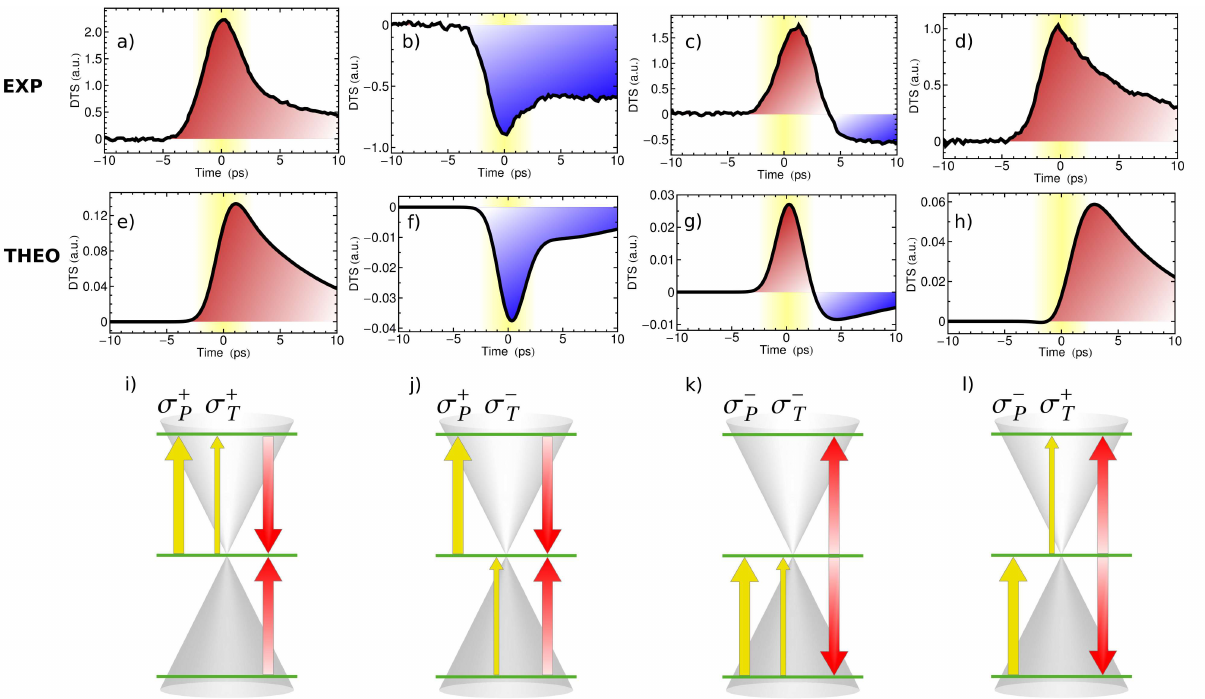
Figure 9: Polarization-resolved differential transmission. Time dependent differential transmission spectra for the four possible cases of combining pump ( σ P ) and probe (or test σ T ) pulse polarization in experiment (upper panel (a)-(d)) and theory (middle panel (e)-(h)). The yellow shaded areas in the background illustrate the width of the pump pulse. The lower panel ((i)-(l)) shows the corresponding sketches illustrating the pump (thick yellow arrows) and probe (thin yellow arrows) pulses, as well as the Auger scattering channels (red